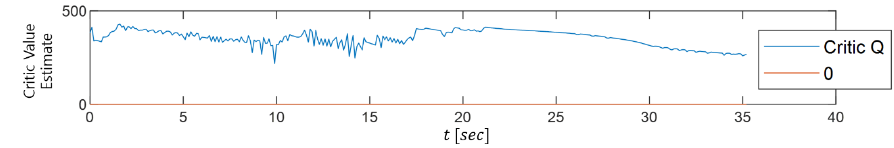
Figure 19. Critic value of the episode in Figure 11.